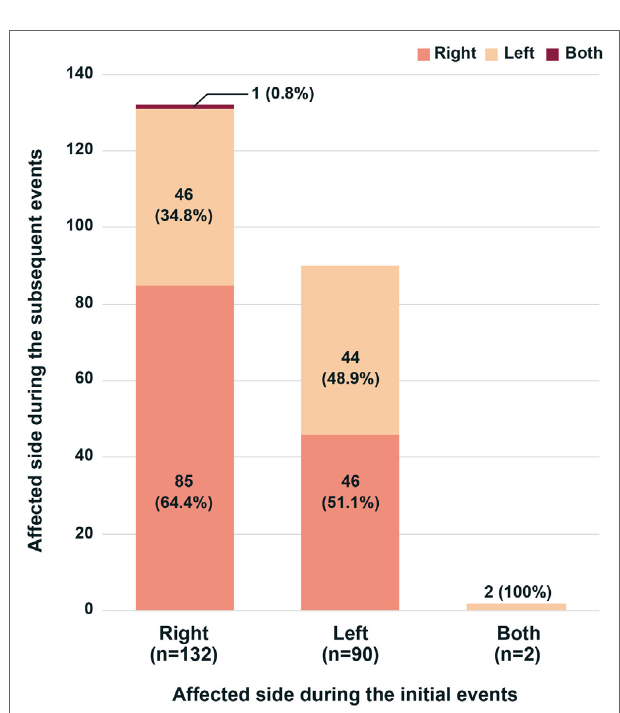
FigUre 2 | Involved sides of benign paroxysmal positional vertigo during recurrences. Irrespective of the side involved during the initial attacks, the proportion of affected sides was similar during the recurrences (Chi-square test, p = 0.123).